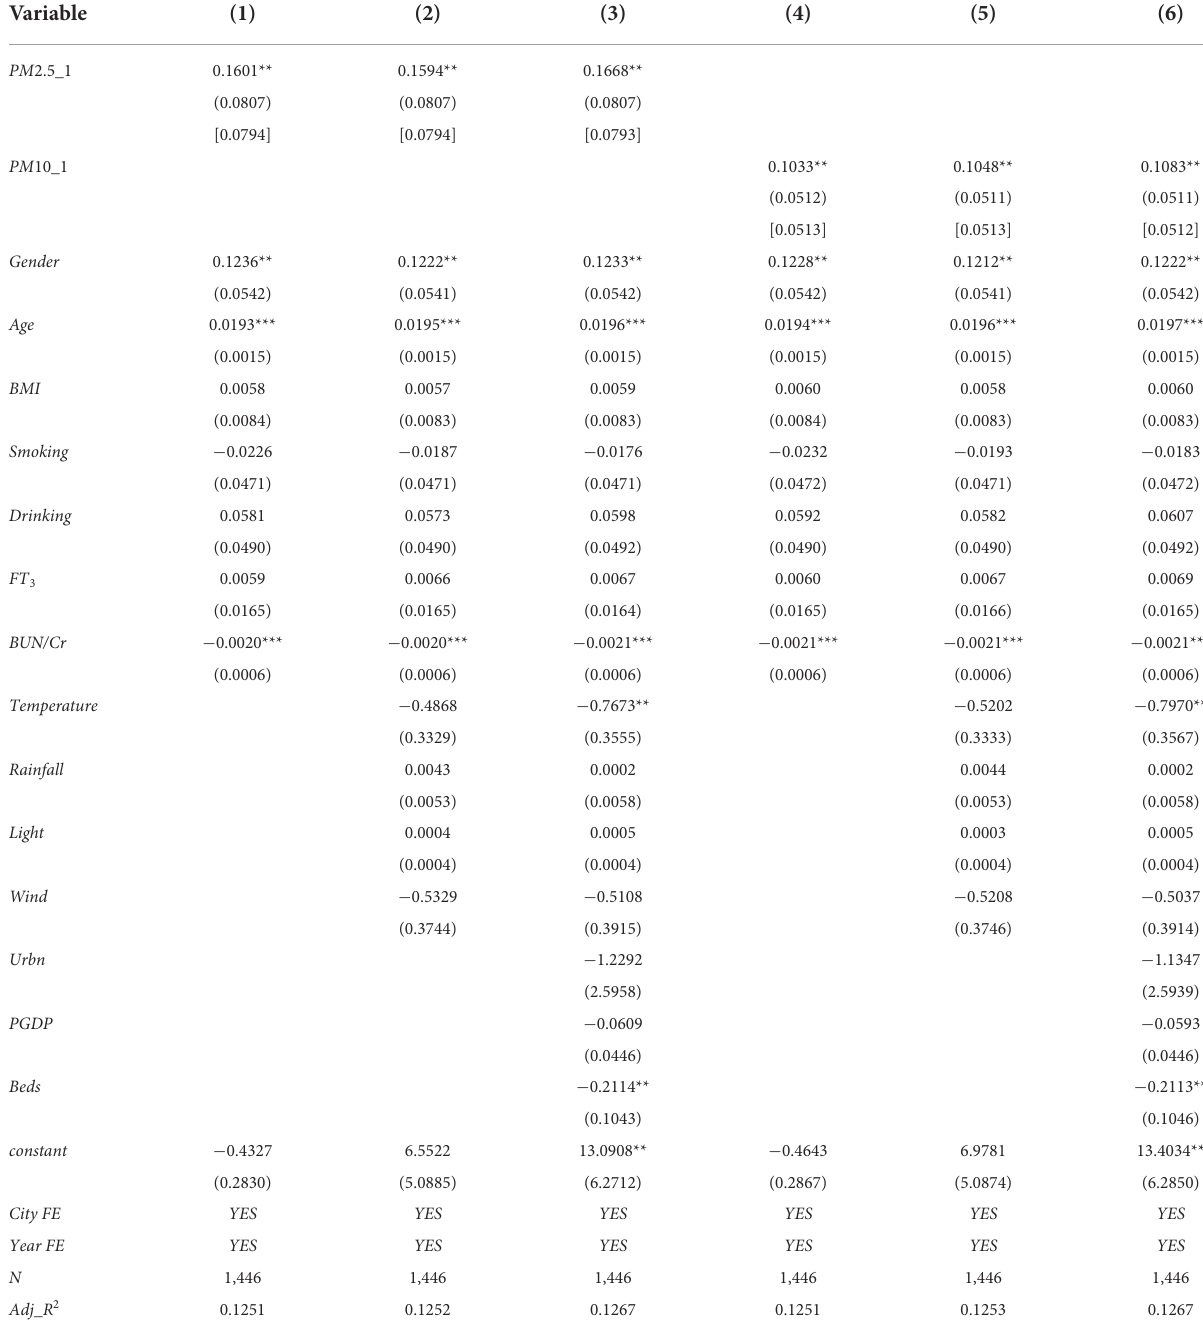
TABLE 2 Benchmark regression